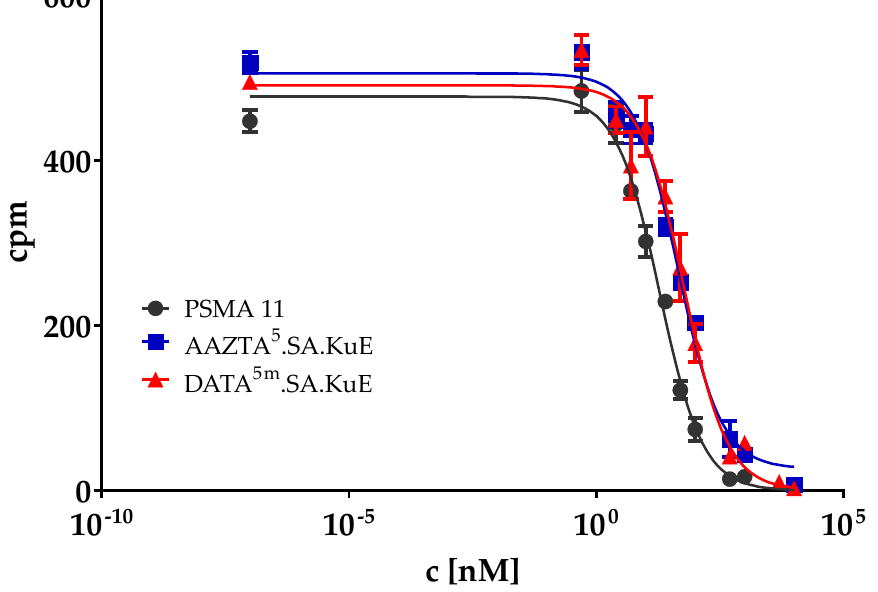
Figure 7. Inhibition curve of AAZTA 5 .SA.KuE, DATA 5m .SA.KuE and PSMA-11. cpm: counts per minute. Table 1. IC 50 values of the investigated compounds. Data represented as mean ± SD (n = 3).